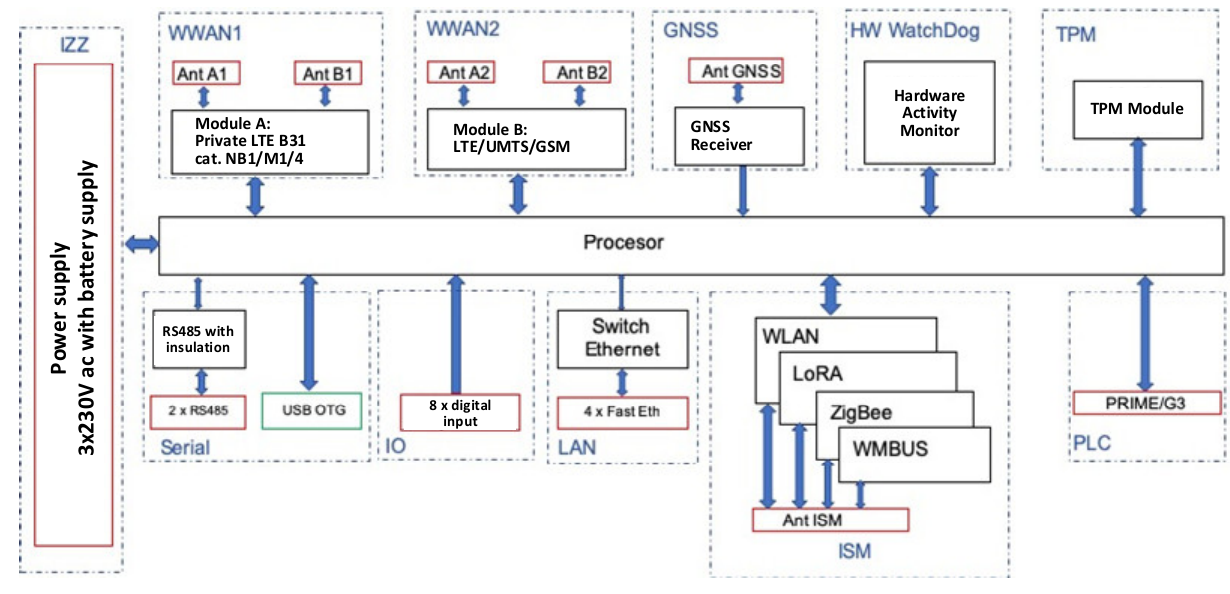
Figure 1. Block diagram of KODEŚ device [4].